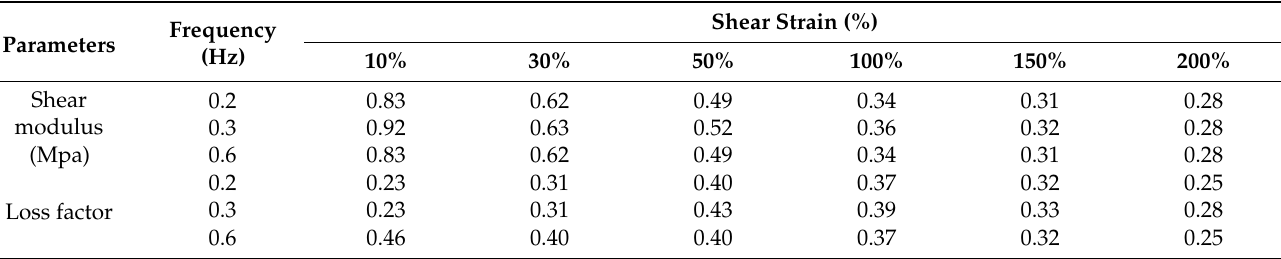
Table 1. Material properties of PR04 rubber.